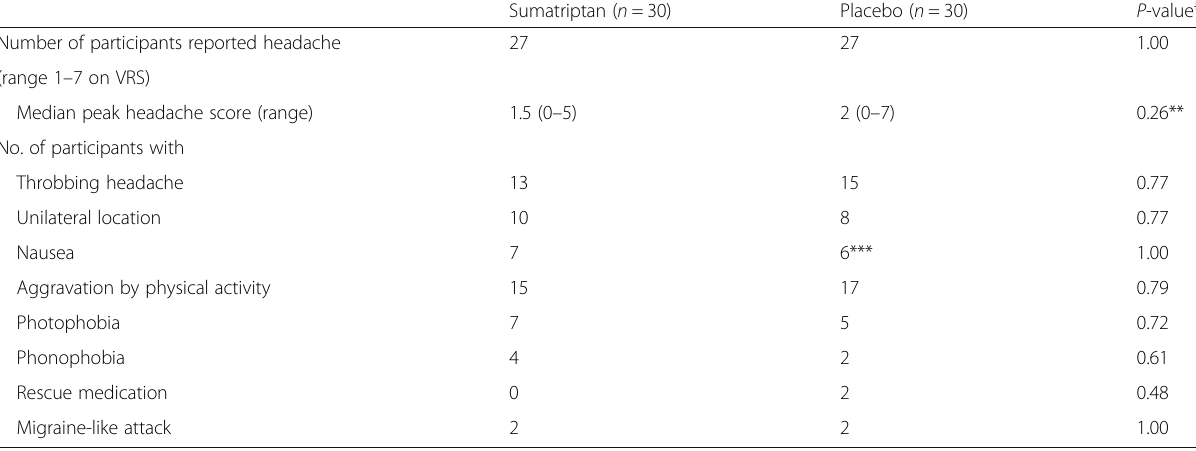
Table 1 Clinical characteristics (our secondary end-point) of headache and associated symptoms after